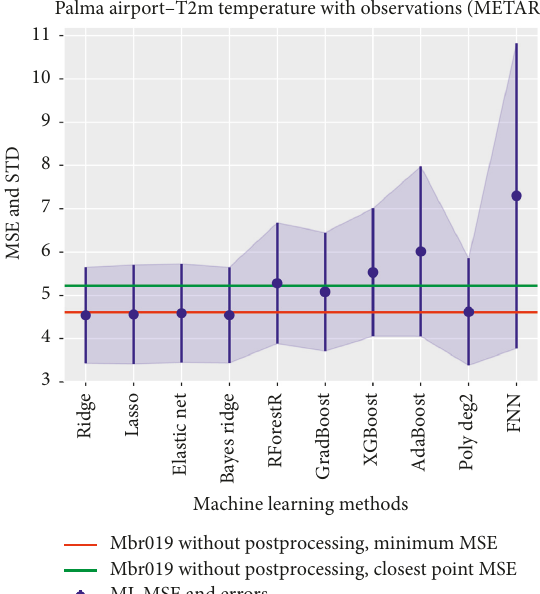
Figure 7: T2m calibration plot for M´alaga airport. Horizontal axis as in Figure 3.